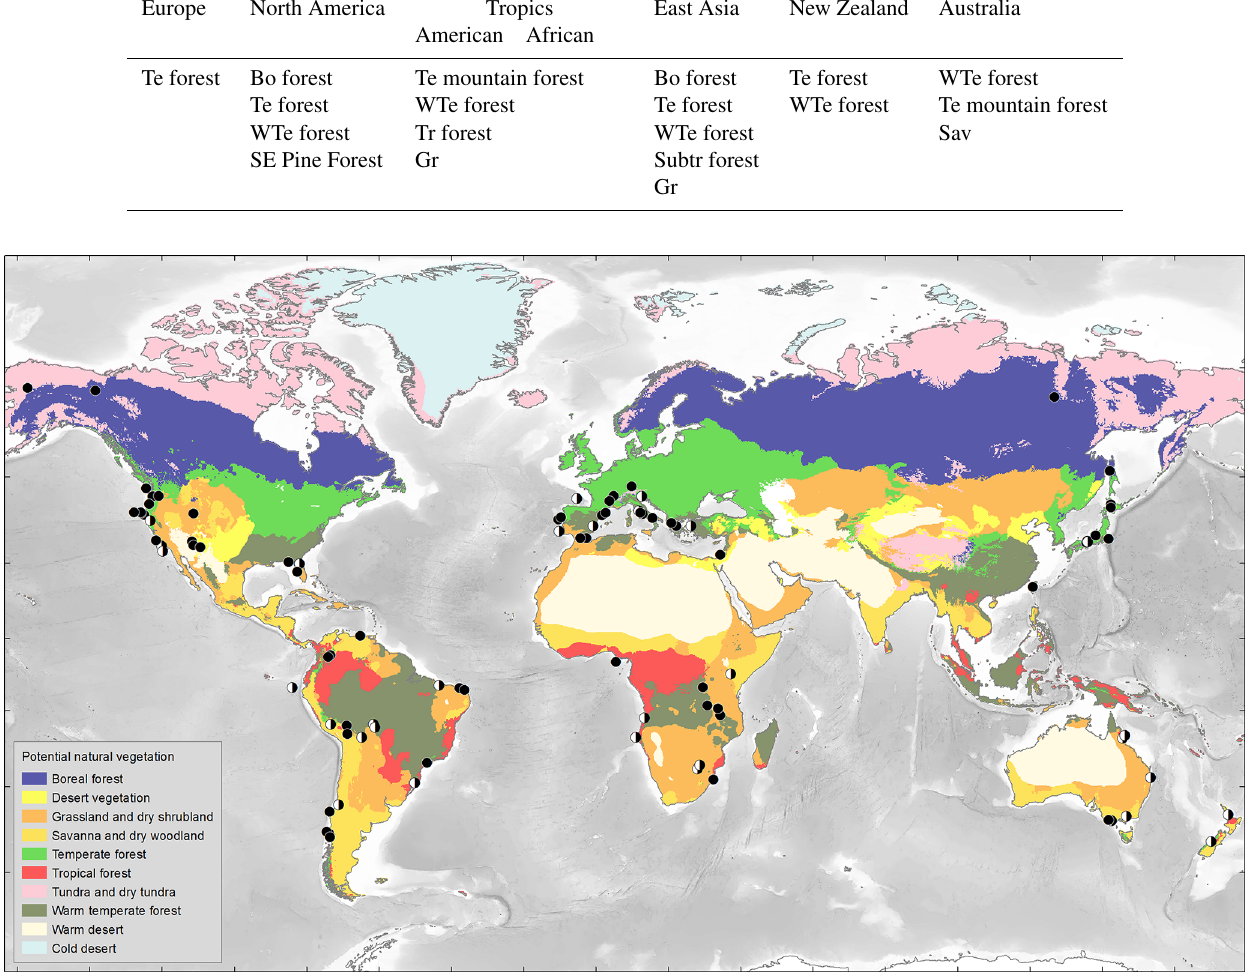
Figure 2. Map with location of the 93 marine and terrestrial pollen sites covering part of or all the last glacial period (MISs 4, 3 and 2). Sites have better resolution than 1 sample per 1000years. Present-day potential natural vegetation after Levavasseur et al.